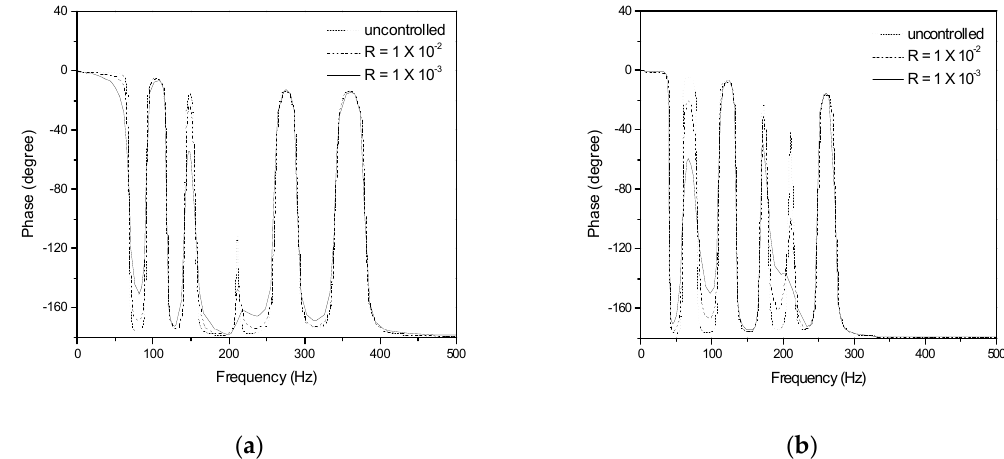
Figure 7. Phase ‐ frequency responses with two locations of stiffener using LQR control: ( a ) Stiffener Figure 7. Phase-frequency responses with two locations of sti ff ener using LQR control: ( a ) Sti ff ener Case 1; ( b ) Stiffener Case 2. Case 1; ( b ) Sti ff ener Case 2.